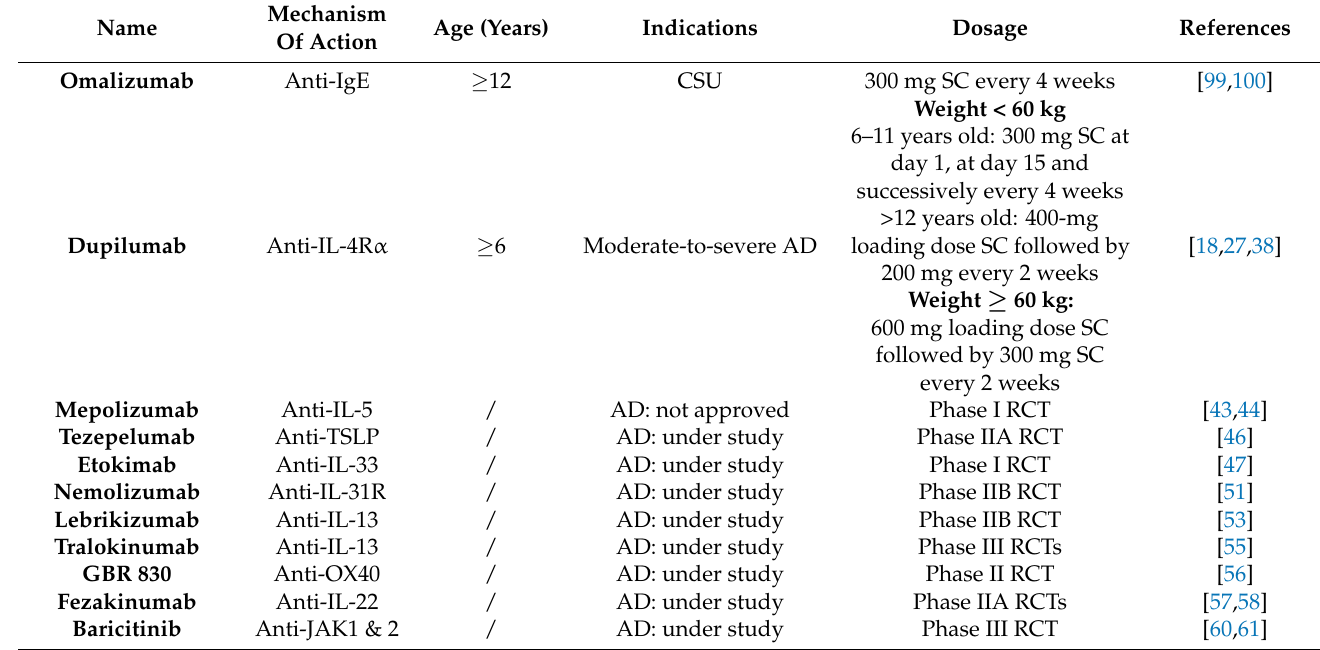
Table 1. Main biologics currently approved and under study for allergic skin diseases in